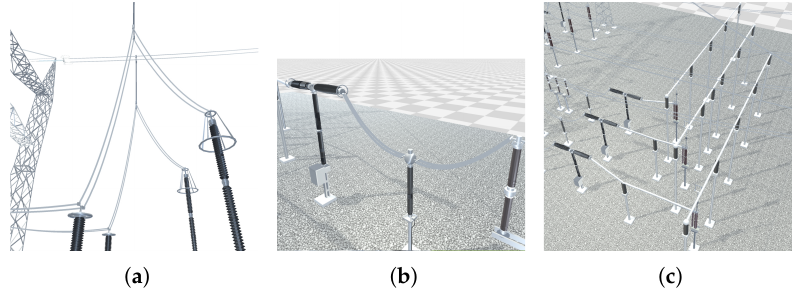
Figure 20. Electric conductors inserted between equipment using the connection references: ( a ) malleable cables connected to the aerial bus; ( b ) malleable cables connected between equipment on the ground; ( c ) rigid